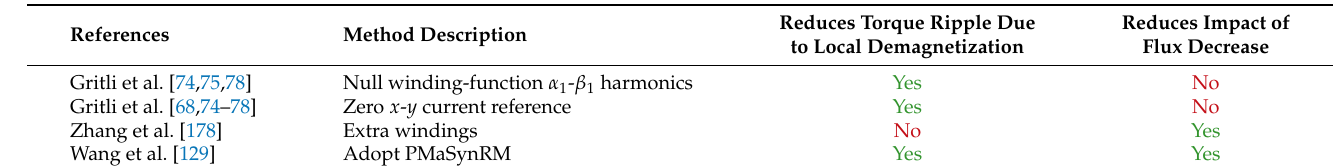
Table 24. Methods for tolerating magnet demagnetization (Section 11.3) in multiphase applications in the